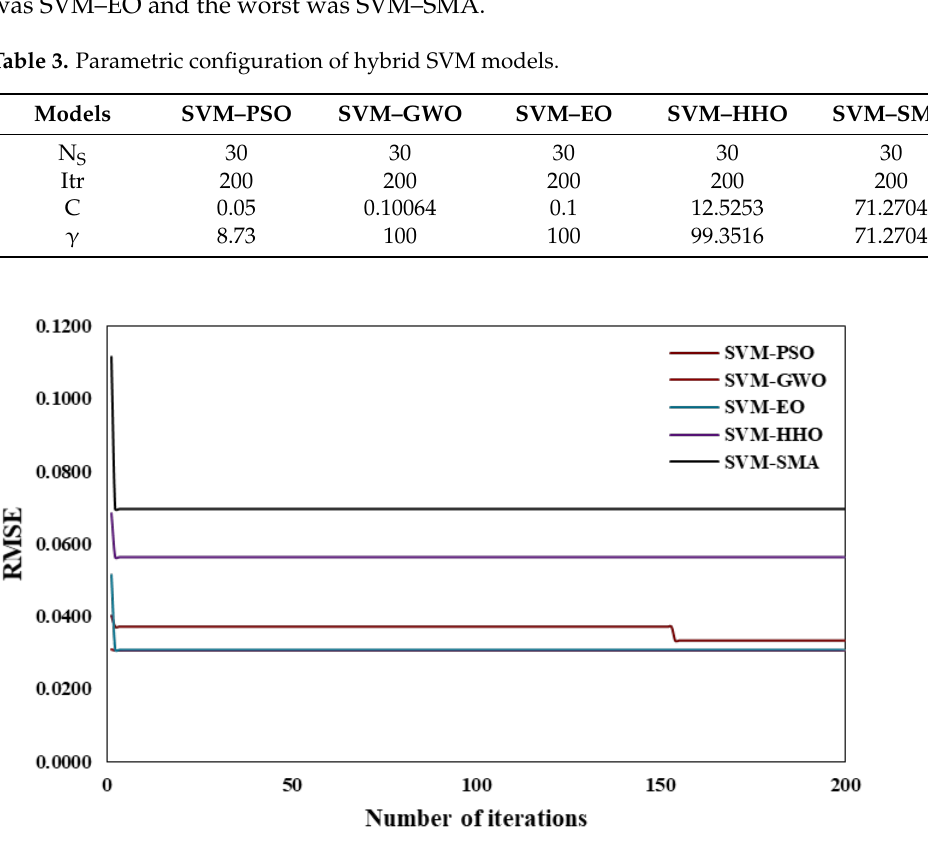
Figure 4. Convergence behavior of hybrid SVM models. Table 3. Parametric configuration of hybrid SVM models.